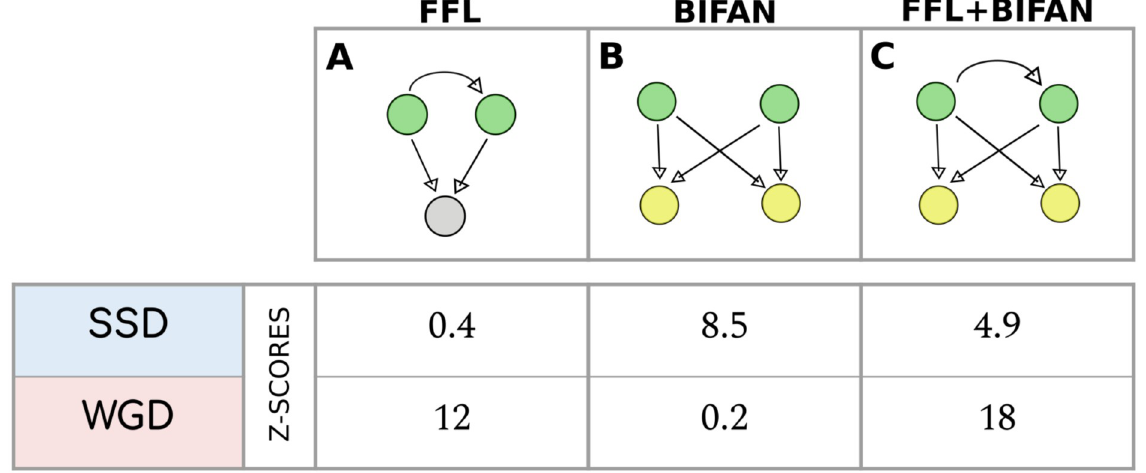
Fig 9. Transcriptional FFL, Bifan and FFL+Bifan motifs. (A) Transcriptional Feed-Forward Loops (FFLs). (B) Transcriptional Bifan motifs (in which no regulatory is present between the two TFs). (C) FLL+Bifan motif. In both (B) and (C) the two regulators and the two targets are duplicated couples of the same type (i.e. both WGD or both SSD